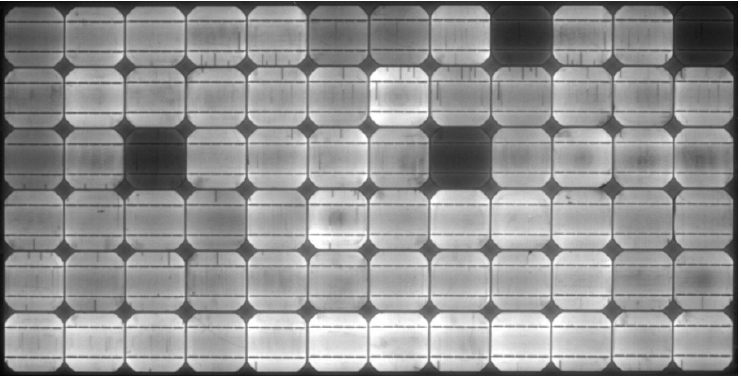
Figure 3. PV panel with visible defects of internal structure